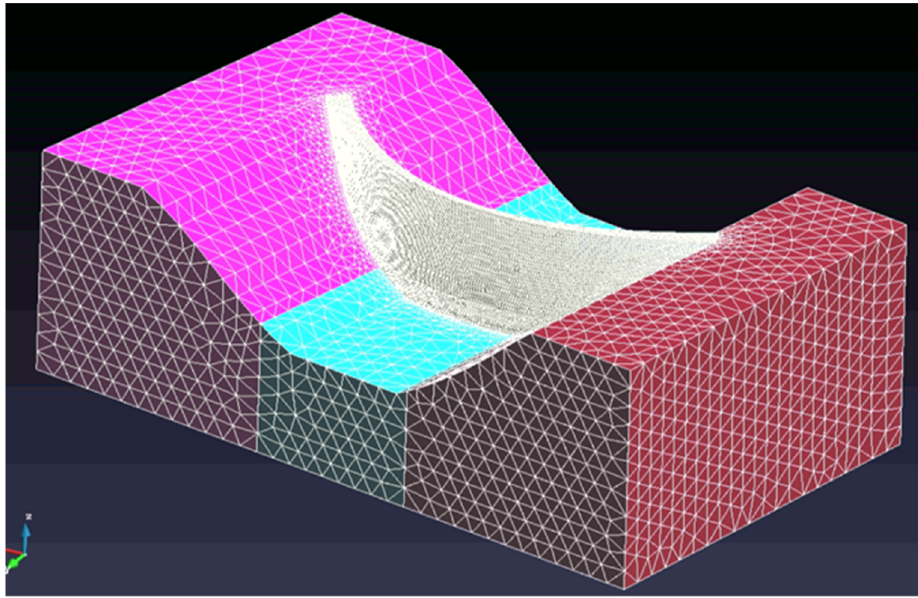
Figure 3. Synthetic dam meshing.